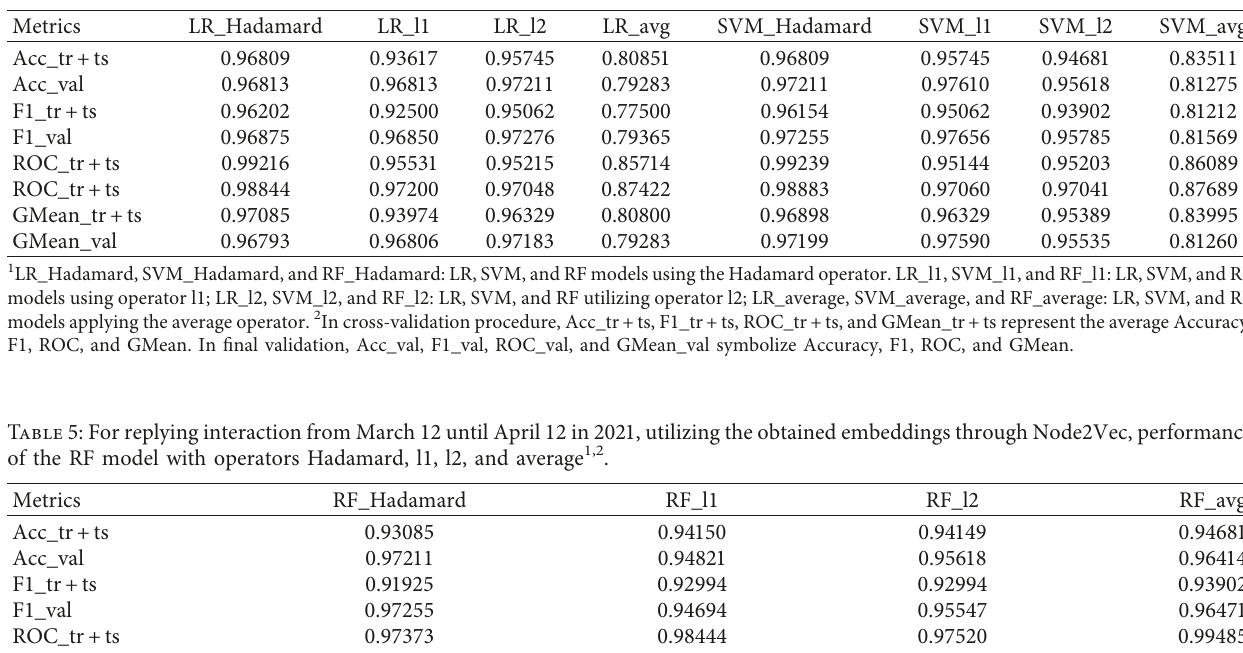
Table 4: For replying interaction from March 12 until April 12 in 2021, utilizing the obtained embeddings through Node2Vec, performance of the LR and SVM models with operators Hadamard, l1, l2, and average 1,2 .